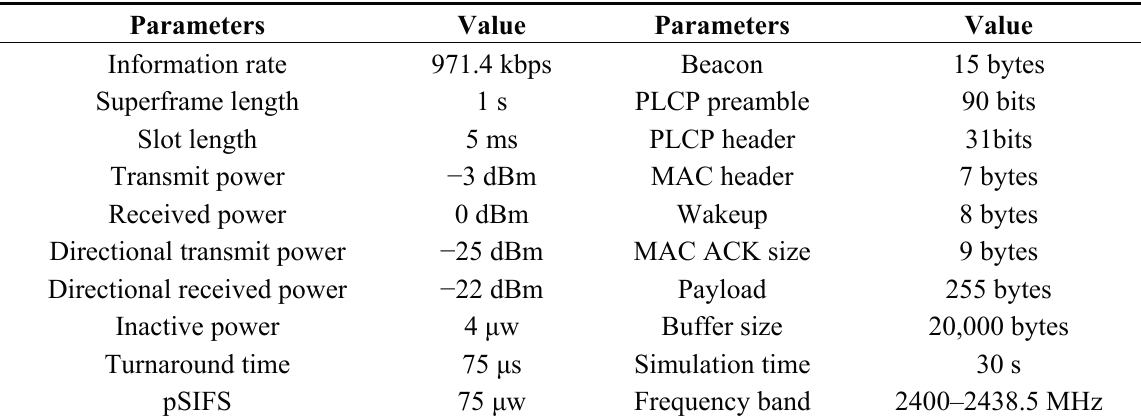
Table 2. Simulation